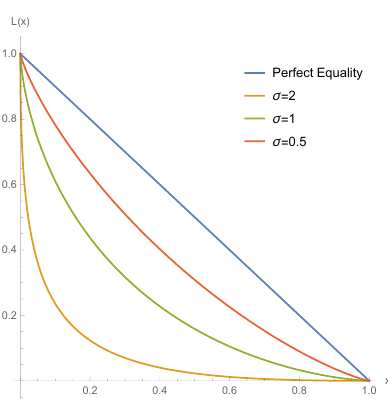
Figure 1: Examples of lognormal generators with different σ parameters.